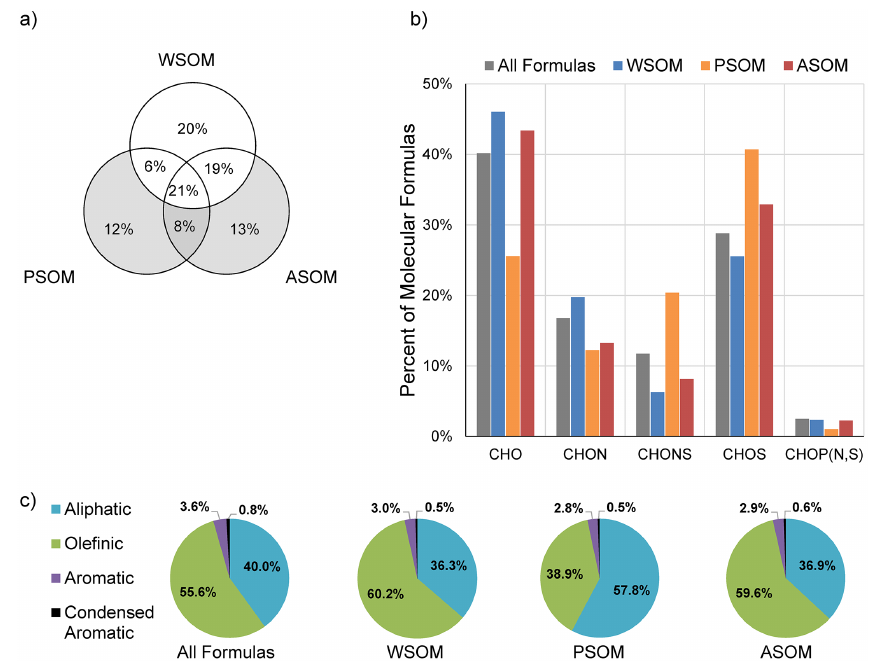
Figure 3. (a) Venn diagram showing the relative distributions of all molecular formulas (5106 total) present in any of the three solvents; grey areas represent WIOM. Percentages in areas of overlap are percentages of molecular formulas that appear in both (or all three) of those samples. Percentages in areas of no overlap are molecular formulas that are unique to that individual sample. (b) Histogram of the fractional contributions (%) of molecular formulas from various elemental combinations to the total for all formulas (5106 total), WSOM formulas (3396 total), PSOM formulas (2397 total), or ASOM formulas (3152 total). (c) Pie charts showing the fractional contributions (%) of molecular structure classes as determined by AI mod